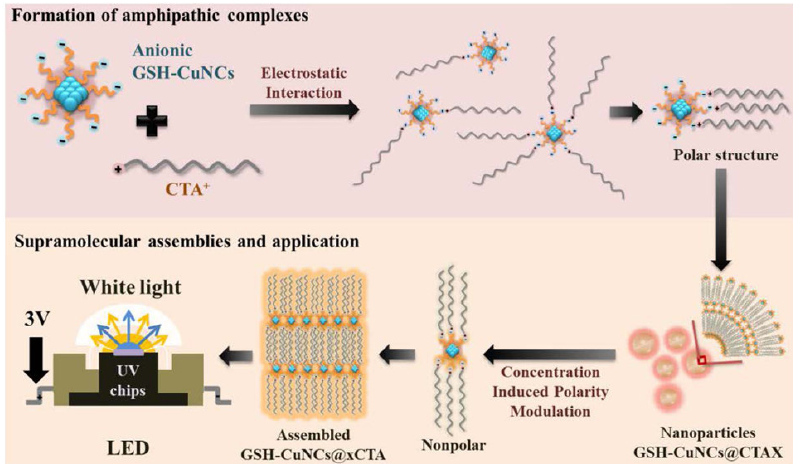
Figure 2. The stepwise assembly of the GSH-CuNCs composite used as a light-emitting diode. Copyright 2021 American Chemical Society.